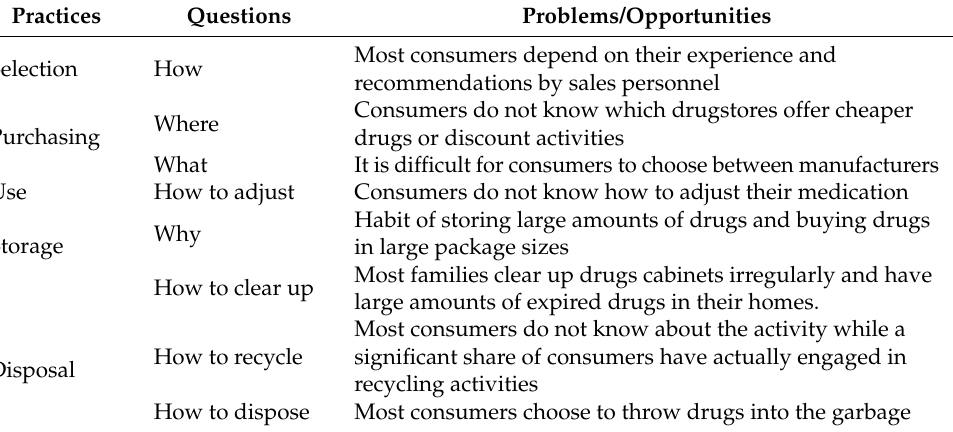
Table 4. Practices and